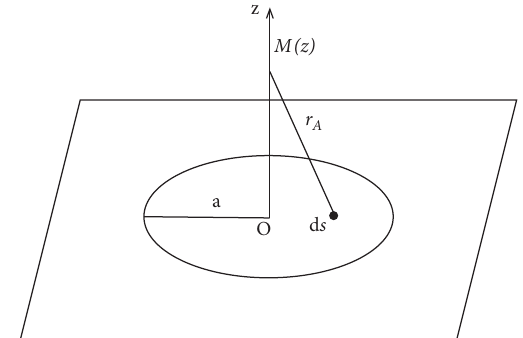
Figure 4: Coordinate frame for the circular knowledge radiator